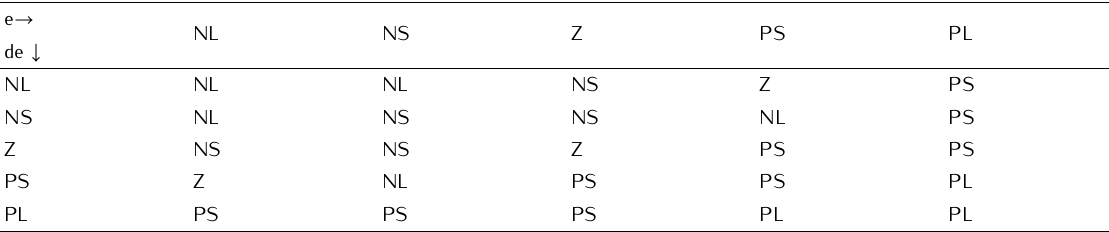
Table 1. Rule base for fuzzy PI